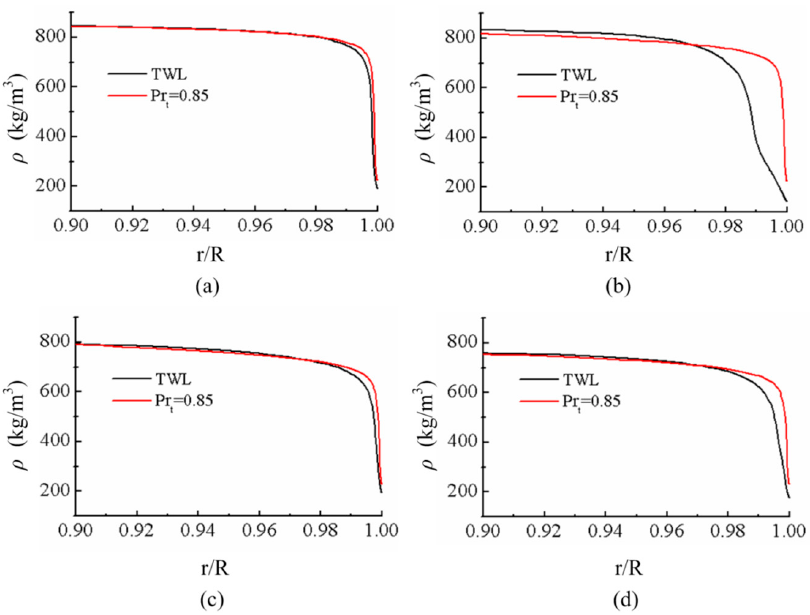
Figure 8. Distribution of density in different sections: ( a ) x/D = 13; ( b ) x/D = 26; ( c ) x/D = 39; ( d ) x/D = 79.